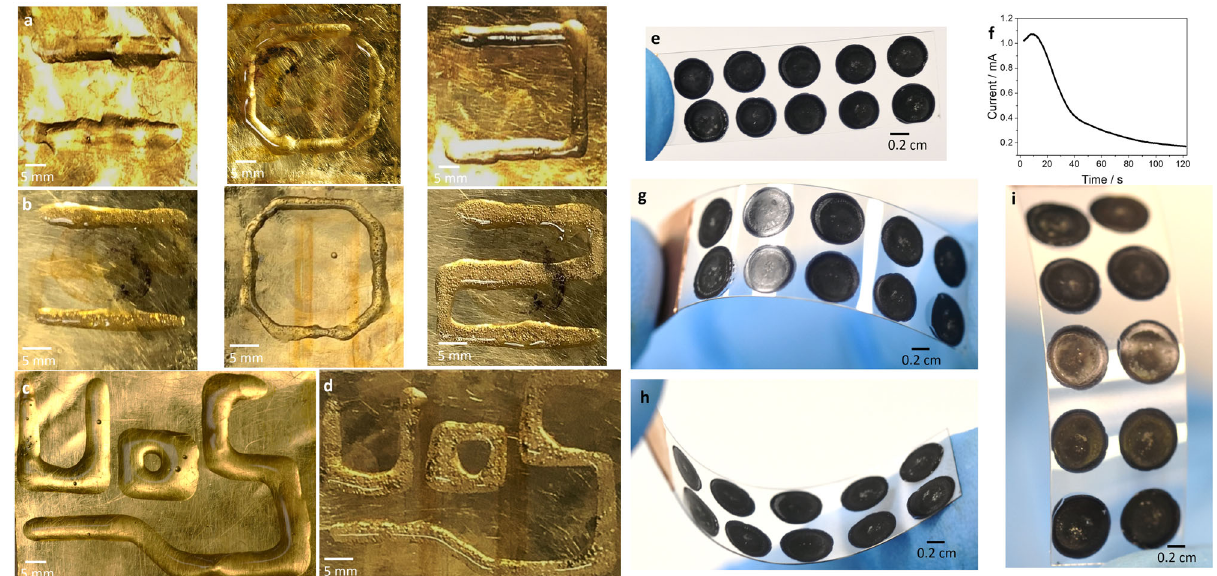
Fig. 5 Electro-assisted hydrogel patterning. a Representative pictures of deposition of different patterns with high M w chitosan (1.8 V) and b alginate (5 V) hydrogels, in lines (left), octagons (middle) and curved paths (right). c Increasing the complexity, the UoS pattern was printed using the high M w chitosan (1.8 V) and d alginate (5 V) hydrogels. e PEDOT/alginate hydrogel dots patterned on a rectangular piece (4.0 × 1.0 cm 2 ) of ITO/PET fl exible substrate. The polymerisation potential is 3 V. f Representative CA pro fi le during deposition of the dots. g – i convex, concave and top view of the substrate with dots under bending,